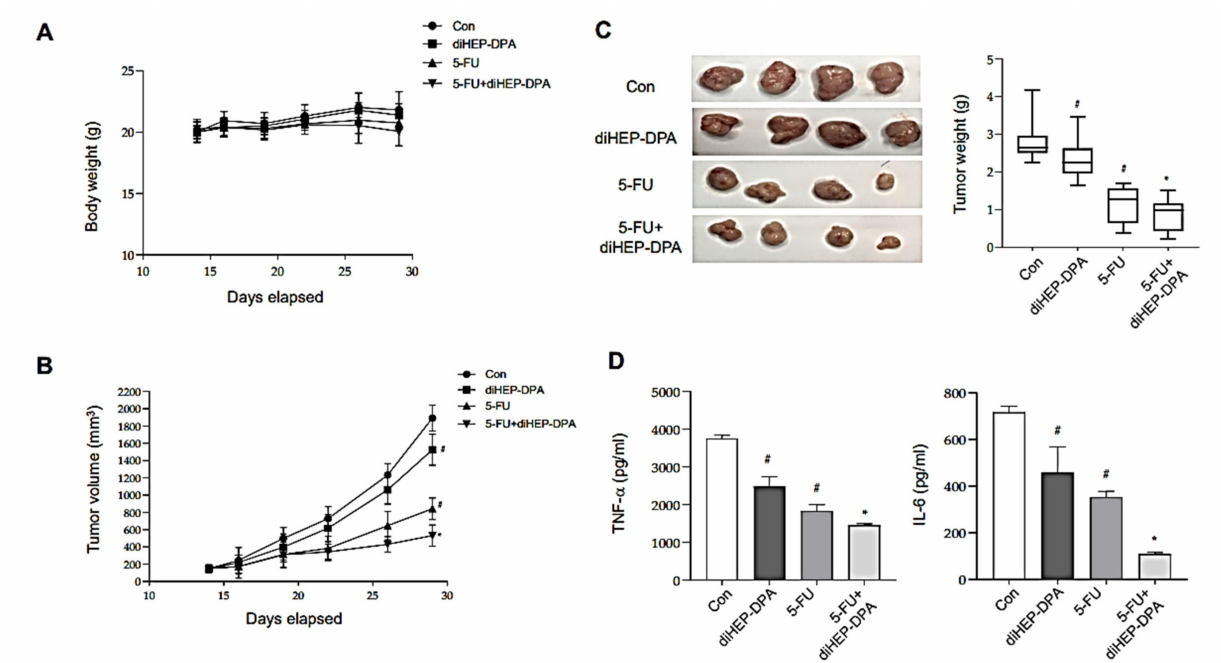
Figure 6. Effect of diHEP-DPA on tumor growth in a xenograft model. A CT26 subcutaneous colorectal tumor model was established by injecting 5 × 10 6 cells into a female BALB/c mouse. Mice were divided into four groups: con (saline), diHEP-DPA (20 µ g/kg), 5-FU (20 mg/kg), and 5-FU + diHEP-DPA. ( A ) Changes in the body weight of tumor-bearing mice with different therapies. ( B , C ) Tumor volume and tumor weights in mice with different therapies. After 2 weeks, mice were sacrificed and tumor specimens were collected, photographed, and weighed. Tumor dimensions were measured two or three times per week using a caliper, and volume was calculated as width 2 × length/2. Tumor growth was monitored throughout the experimental period. Tumor weights were measured after therapy. ( D ) Concentrations of inflammatory cytokines (TNF- α and IL-6) in serum, assayed on day 30. Data are presented as the means ± SD of three independent experiments ( # p < 0.05 versus the DMSO-treated control group; * p < 0.05 versus the 5-FU